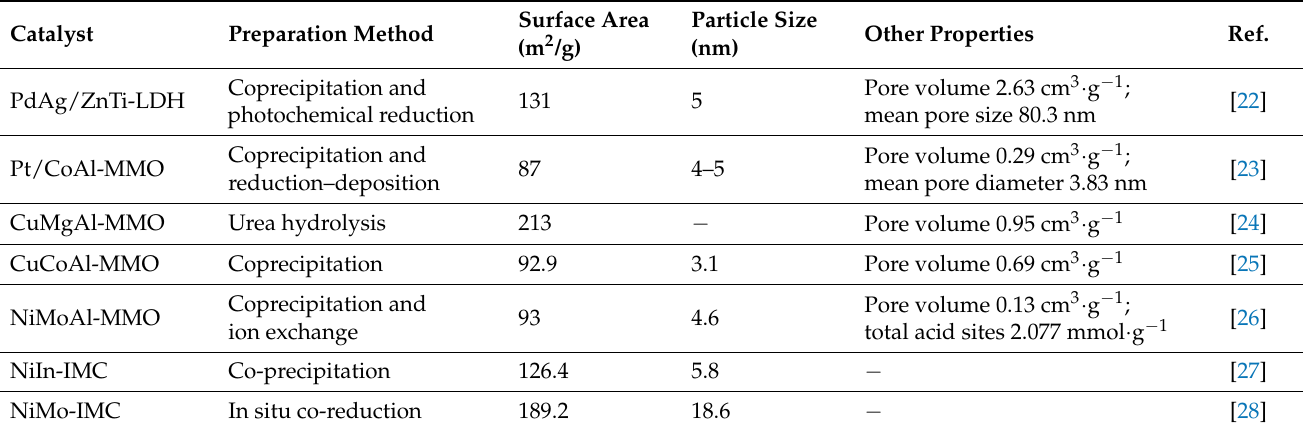
Table 1. Examples of LDH-derived catalysts prepared with different